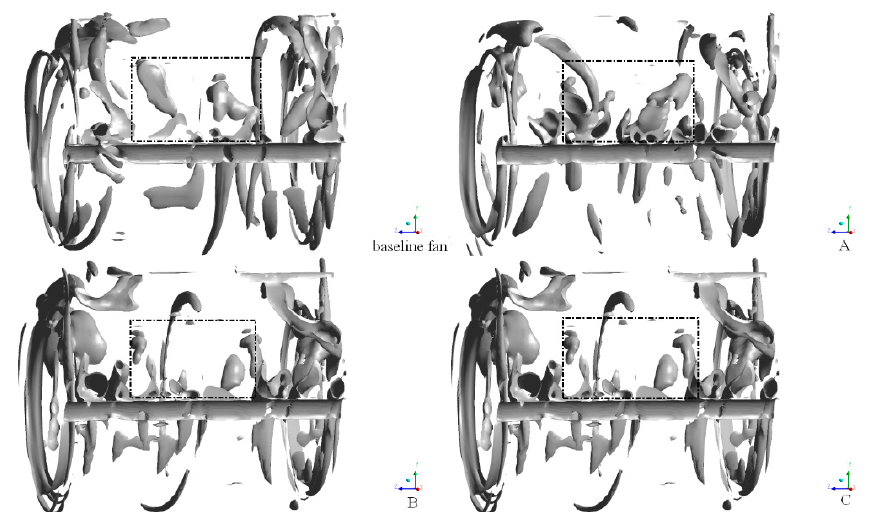
Figure 24. Three-dimensional distribution of vortices in volutes at Q / Q n = 1.000.